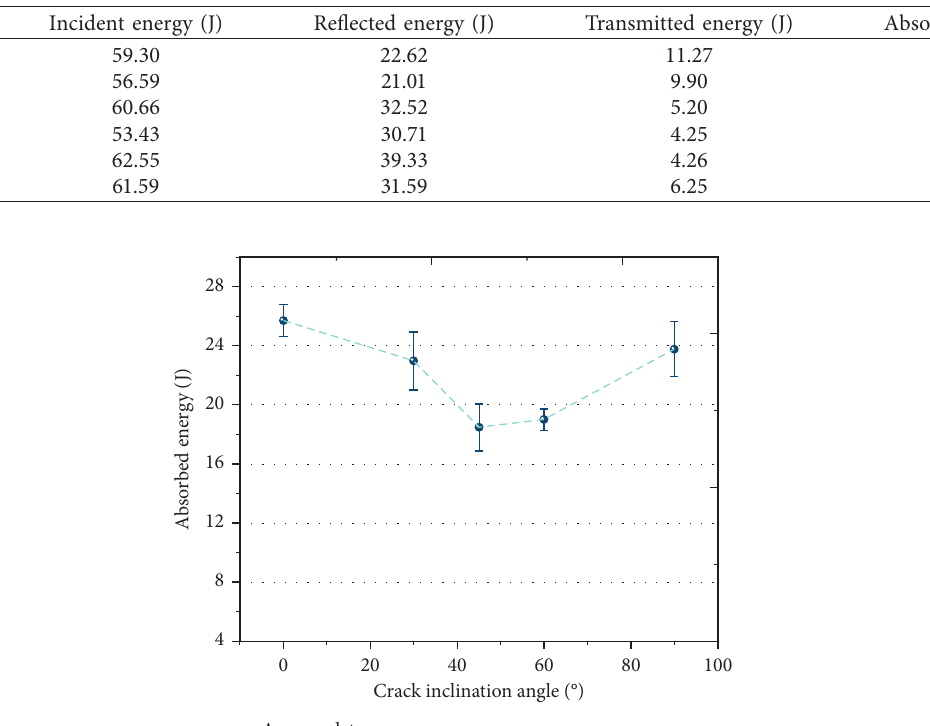
A and the flaw inclination angle.